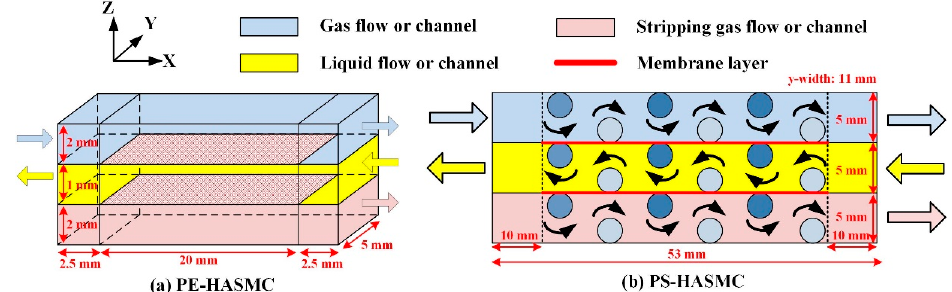
Figure 1. Parallel-flow hybrid absorption/stripping membrane contactors (HASMCs) with ( a ) empty channels or ( b ) spacer-filled channels.